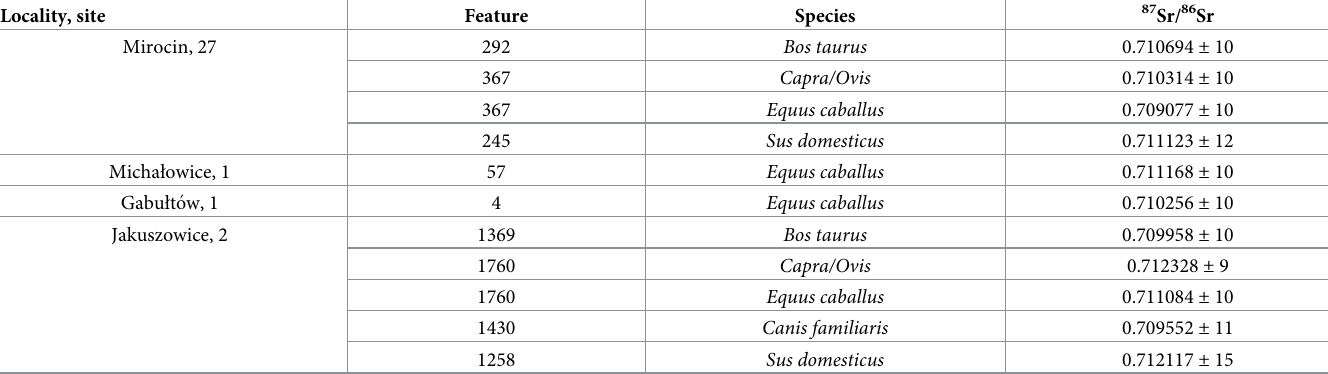
Table 3. Strontium isotope ratios for animal enamel samples from the investigated sites of south-eastern Poland. Locality, site